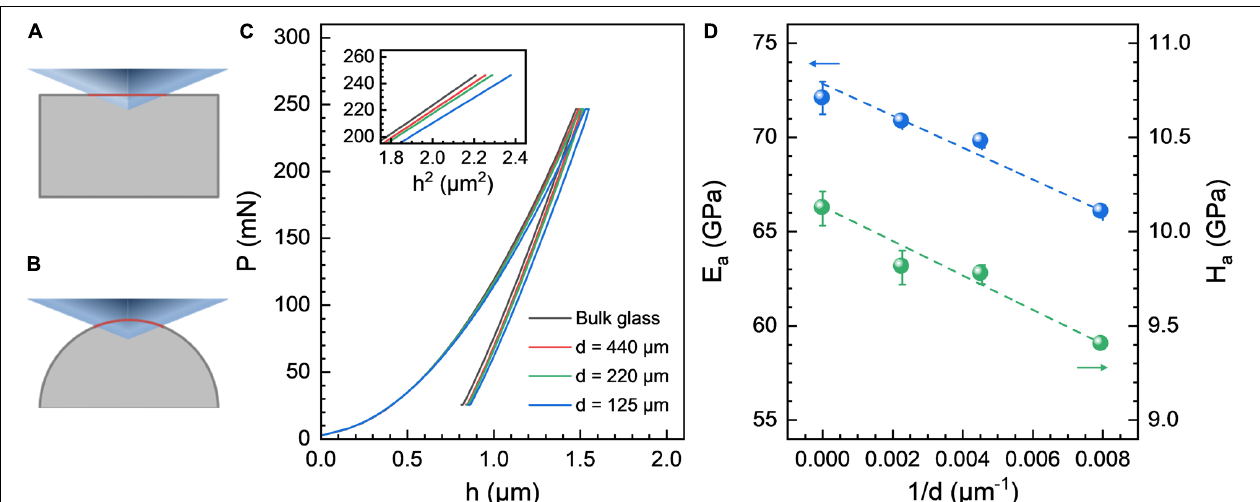
Frontiers in Materials |